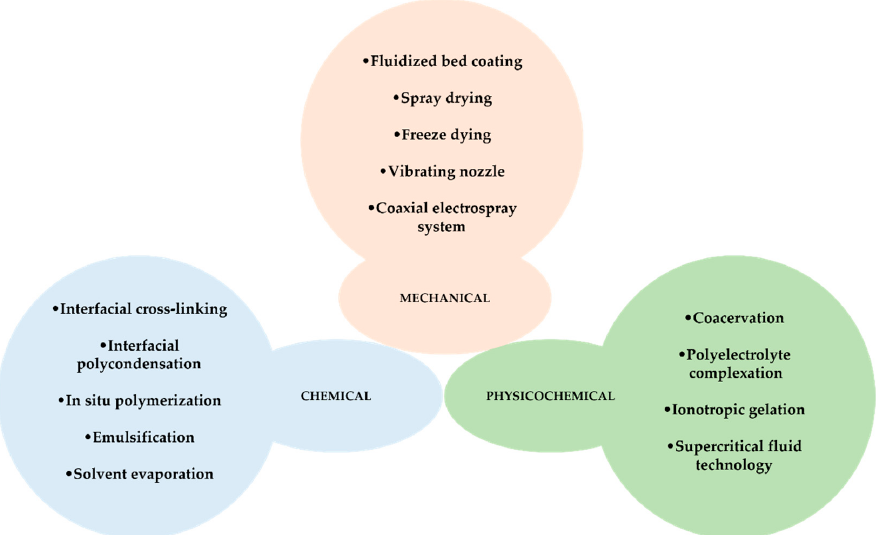
Figure 8. Main microencapsulation methods.